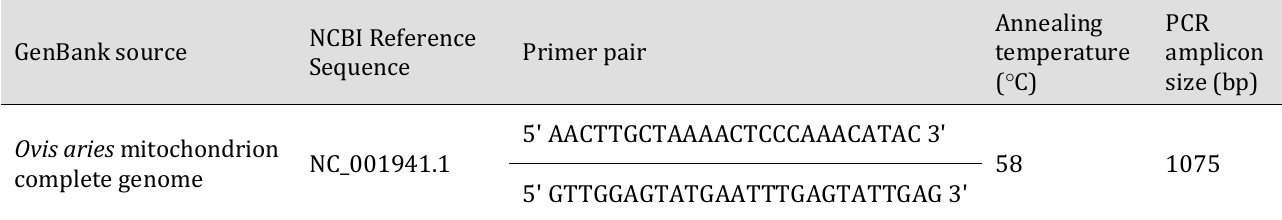
Table 2. Specific primer sequences, amplicon size, and the annealing temperature GenBank